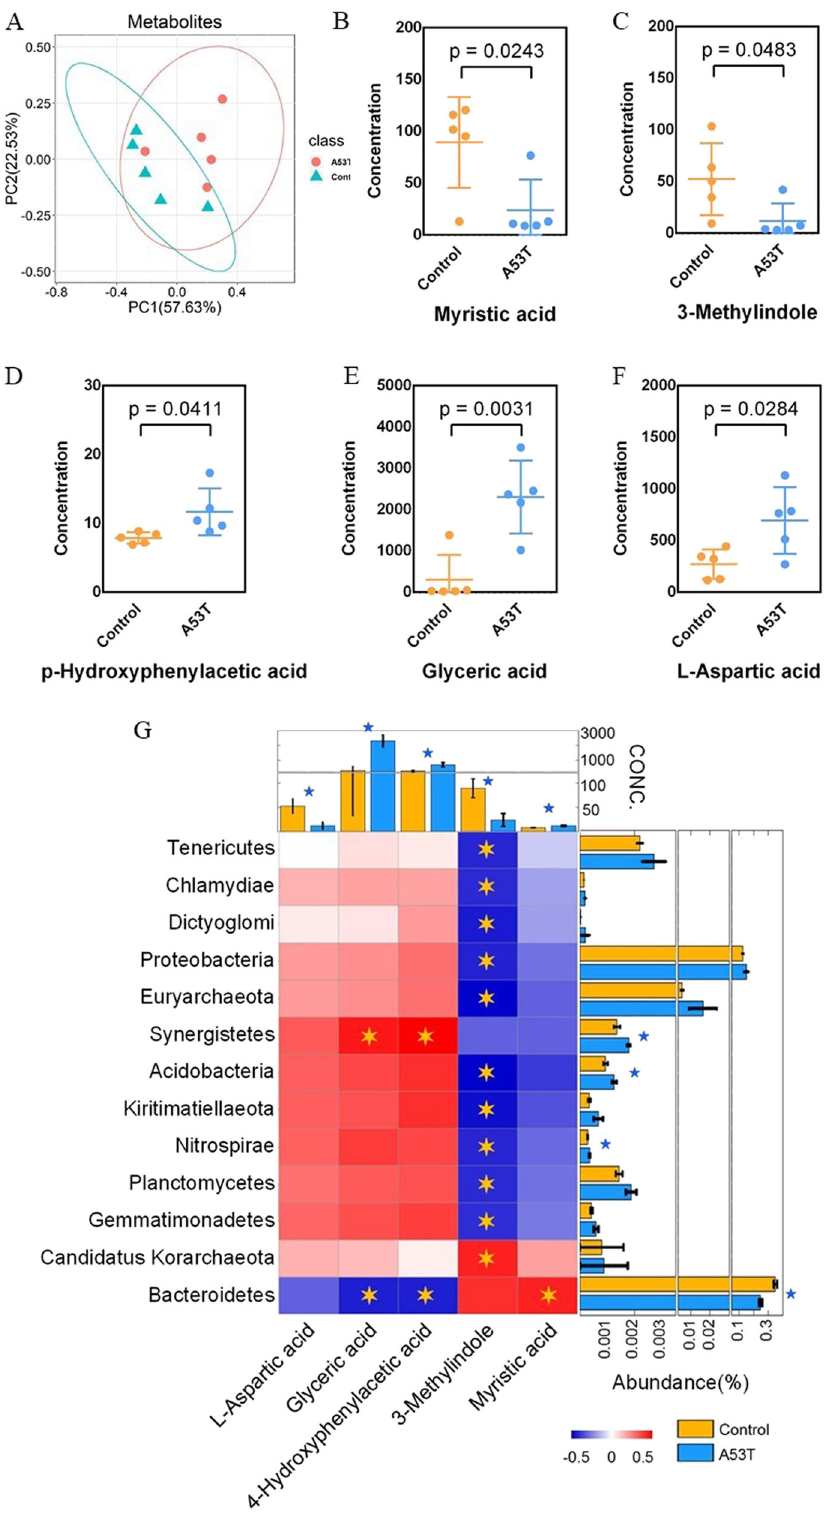
Fig. 2 Microbiota from A53T transgenic and control monkeys produce discrete metabolite pro fi les and correlation analysis. A Metabolites had obviously divided between A53T transgenic monkeys and control monkeys. B – C ) Myristic acid, 3-Methylindole signi fi cantly ( p < 0.05) decreased in A53T group. D – F p-Hydroxyphenylacetic acid, Glyceric acid, and L-Aspartic acid signi fi cantly ( p < 0.05) increased in A53T transgenic group. The concentrations of different metabolites in the A53T transgenic and control groups were compared with Welch ’ s t tests and the obtained p-values were corrected with the Benjamini Hochberg method. G Analyze the correlation between bacteria and metabolites. Glyceric acid and p-Hydroxyphenylacetic are positively correlated with Sybergistetes. Myristic acid and Bacteroidetes are signi fi cant positive correlated. Candidatus Korarchaeota and 3-Methylindole are positive